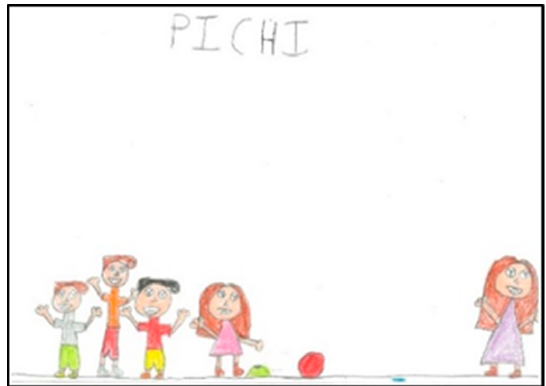
Figure 10. Clothes they identify with. Félix. 1°B.